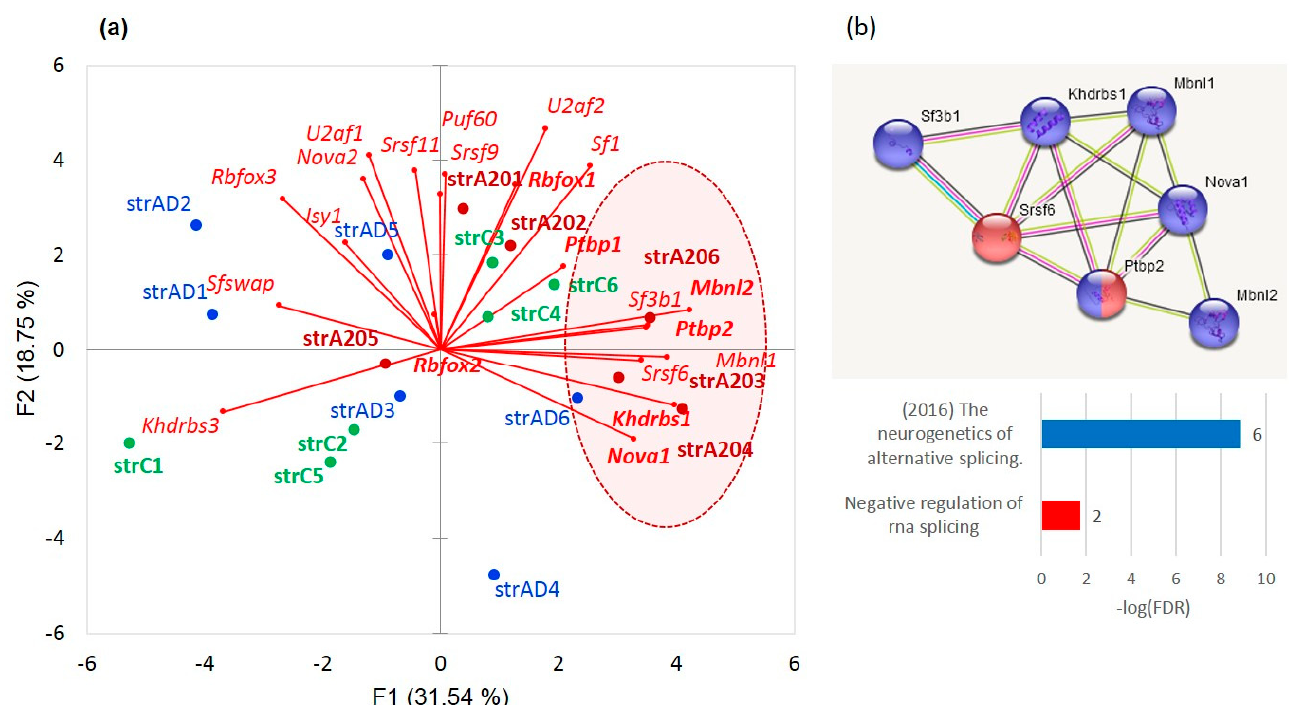
Figure 22. ( a ). Distribution of the SFs across the groups of mice. We observed five out of six A20 samples in the right side of the plot (random chance p < 0.016 based on a binomial test), implying consistent elevated expression of particular SF subsets for this group. Boldfaced are the SFs mentioned in [56], which maintain Grin1 and Dlg4 ( Psd95 ) isoforms were tuned up (encircled with red shaded oval). ( b ). The coordinated cluster of the SF factors encircled in ( a ) represents the annotated coordinated SF network reported, in particular, in [56].